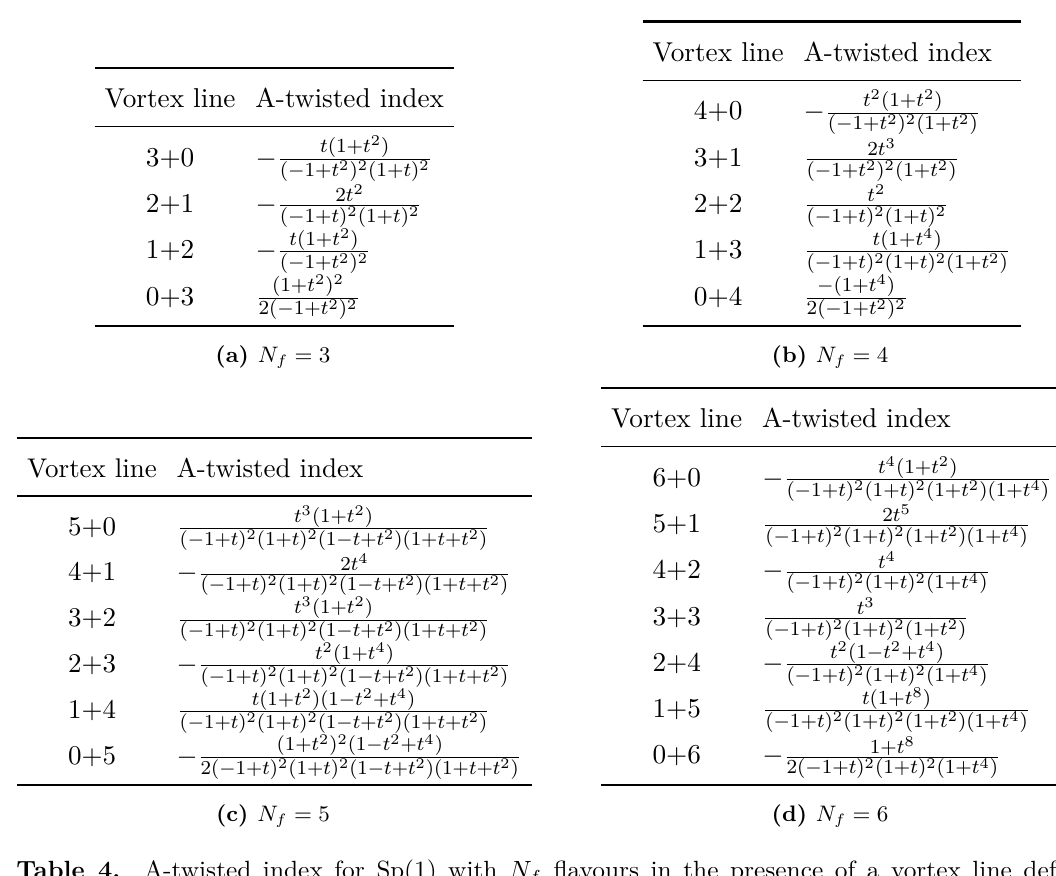
Table 4. A-twisted index for Sp(1) with N f flavours in the presence of a vortex line defect characterised by a splitting L + ( N ) and the fundamental representation of Sp(1) . f − L